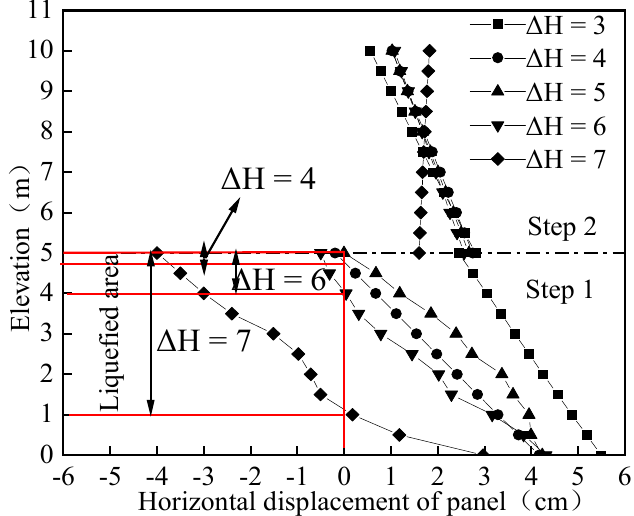
Δ on horizontal displacement of panel. Figure 11. Influence of ∆ H on horizontal displacement of